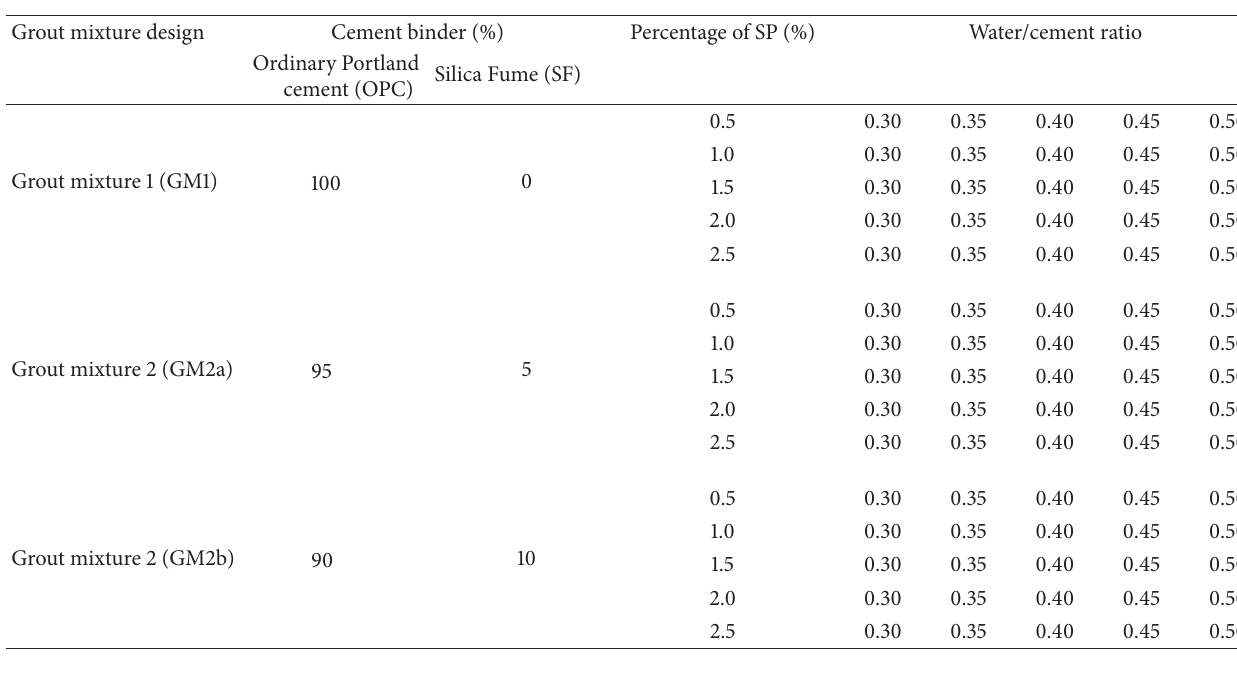
Table 1: Mixture proportions.